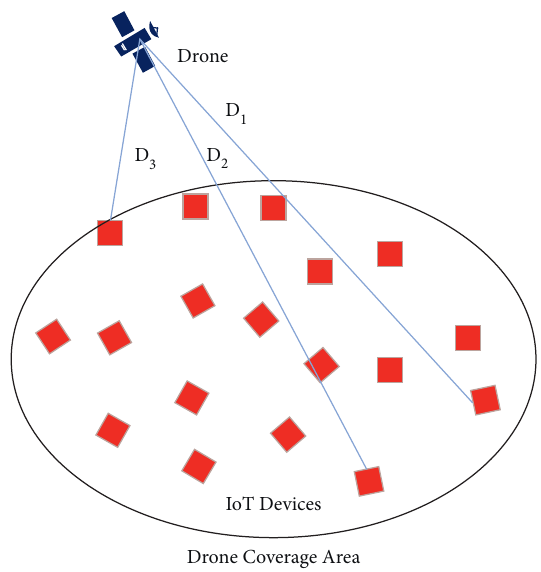
Figure 6: Signal quality at various